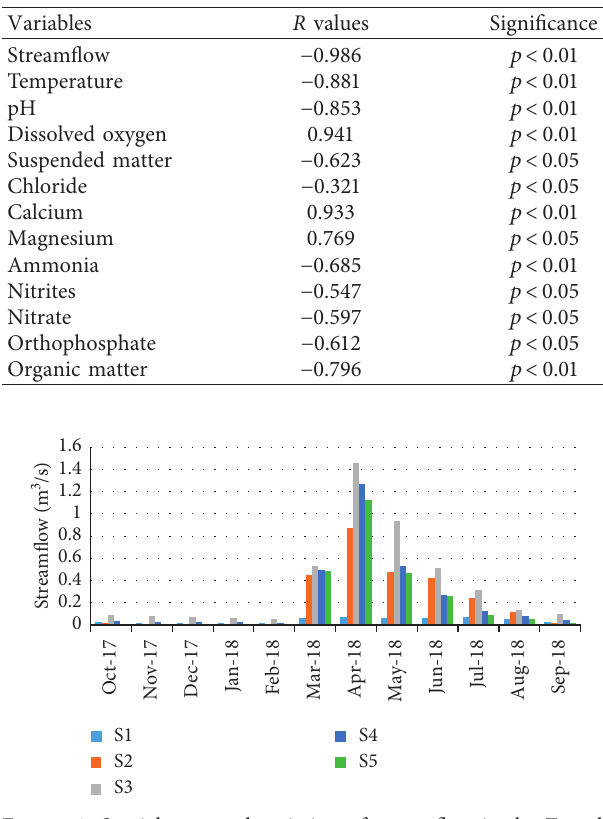
Figure 3: Spatial-temporal variation of streamflow in the Zegzel